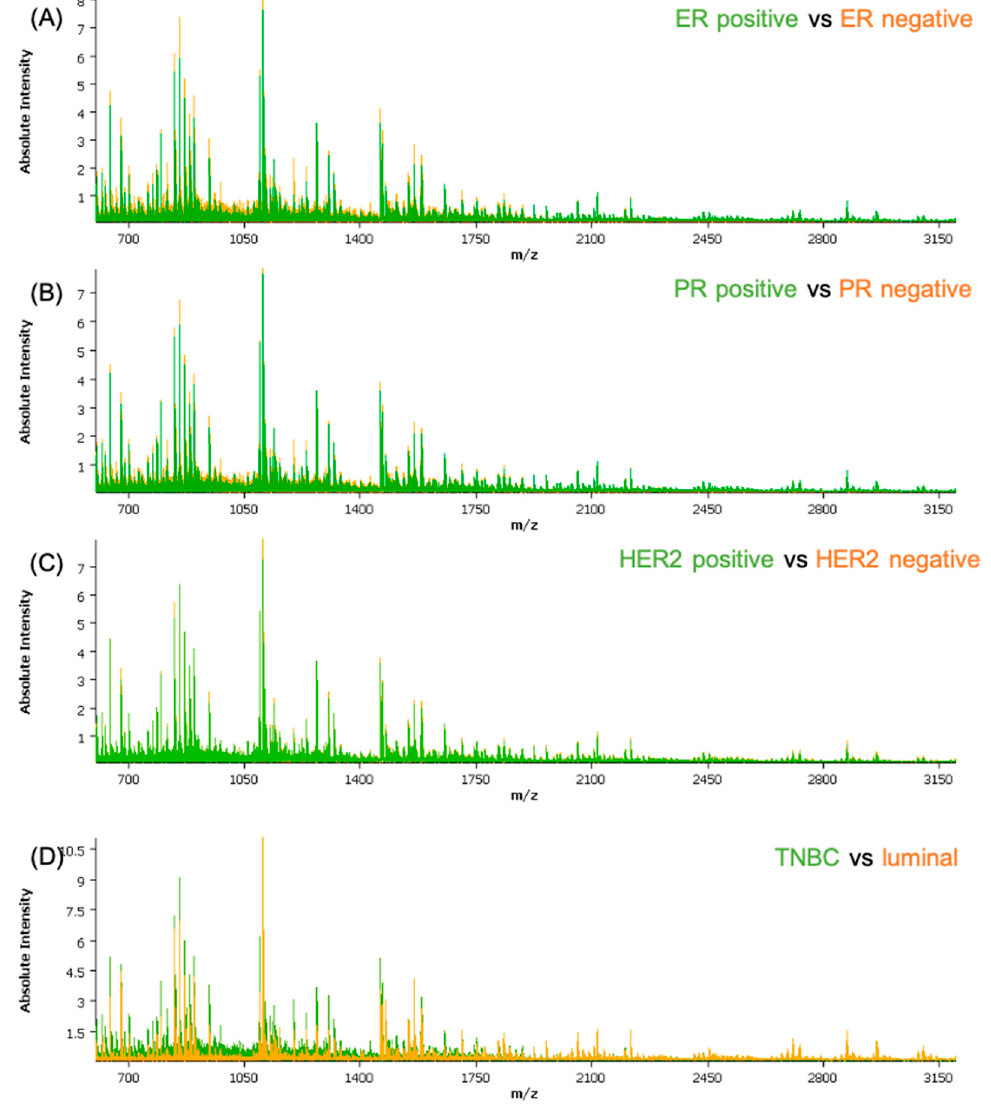
Figure 1. Comparison between the average spectra of the different classes used in the classification models: ( A ) ER-positive versus ER-negative; ( B ) PR-positive versus PR-negative; ( C ) HER2-positive versus HER2-negative; and ( D ) TNBC versus luminal. ER—estrogen receptor; PR—progesterone receptor; HER2—human epidermal growth factor receptor-2.